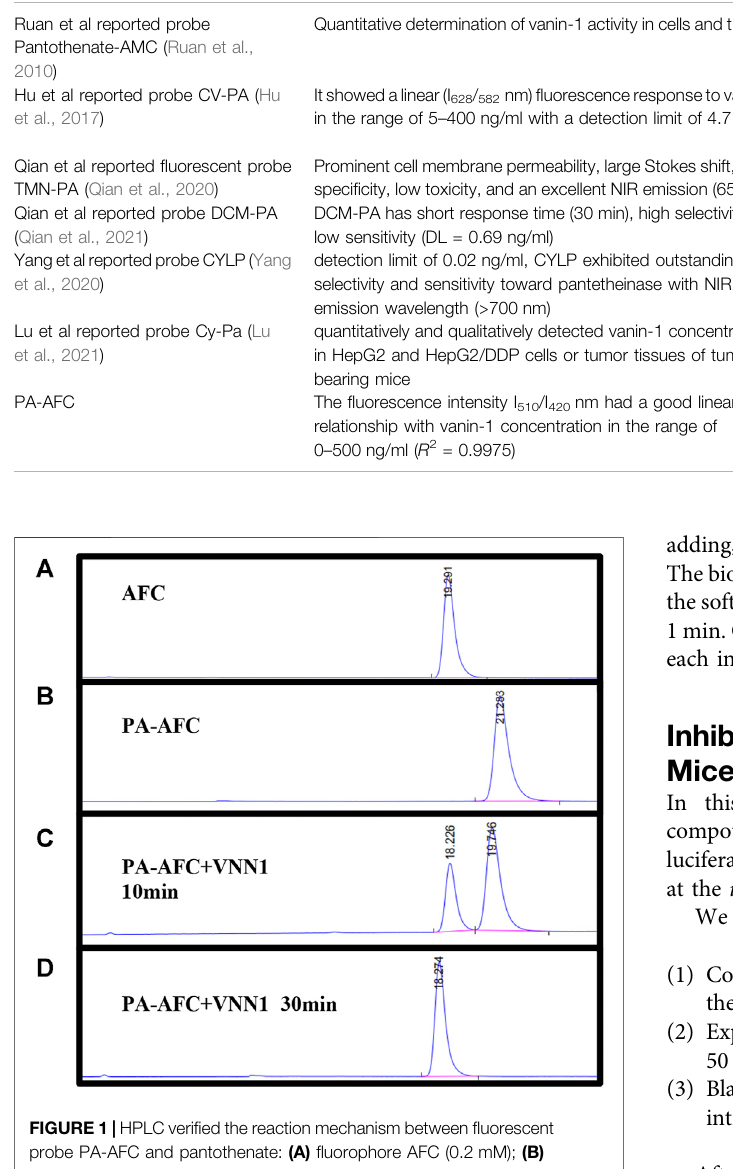
Frontiers in Chemistry |